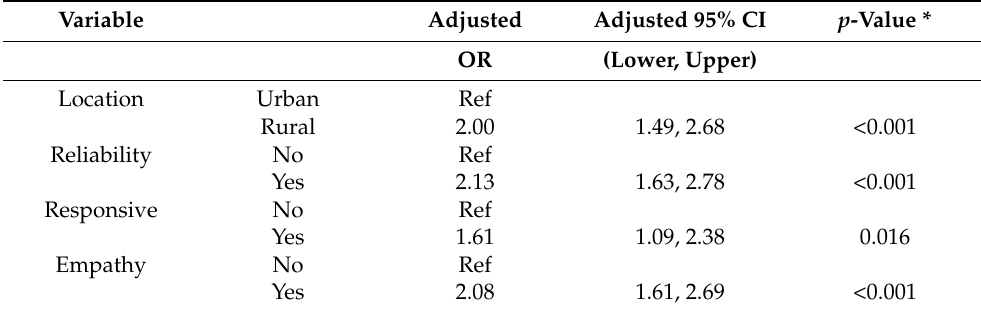
Table 4. Factors associated with patient dissatisfaction in multivariable analysis ( n =